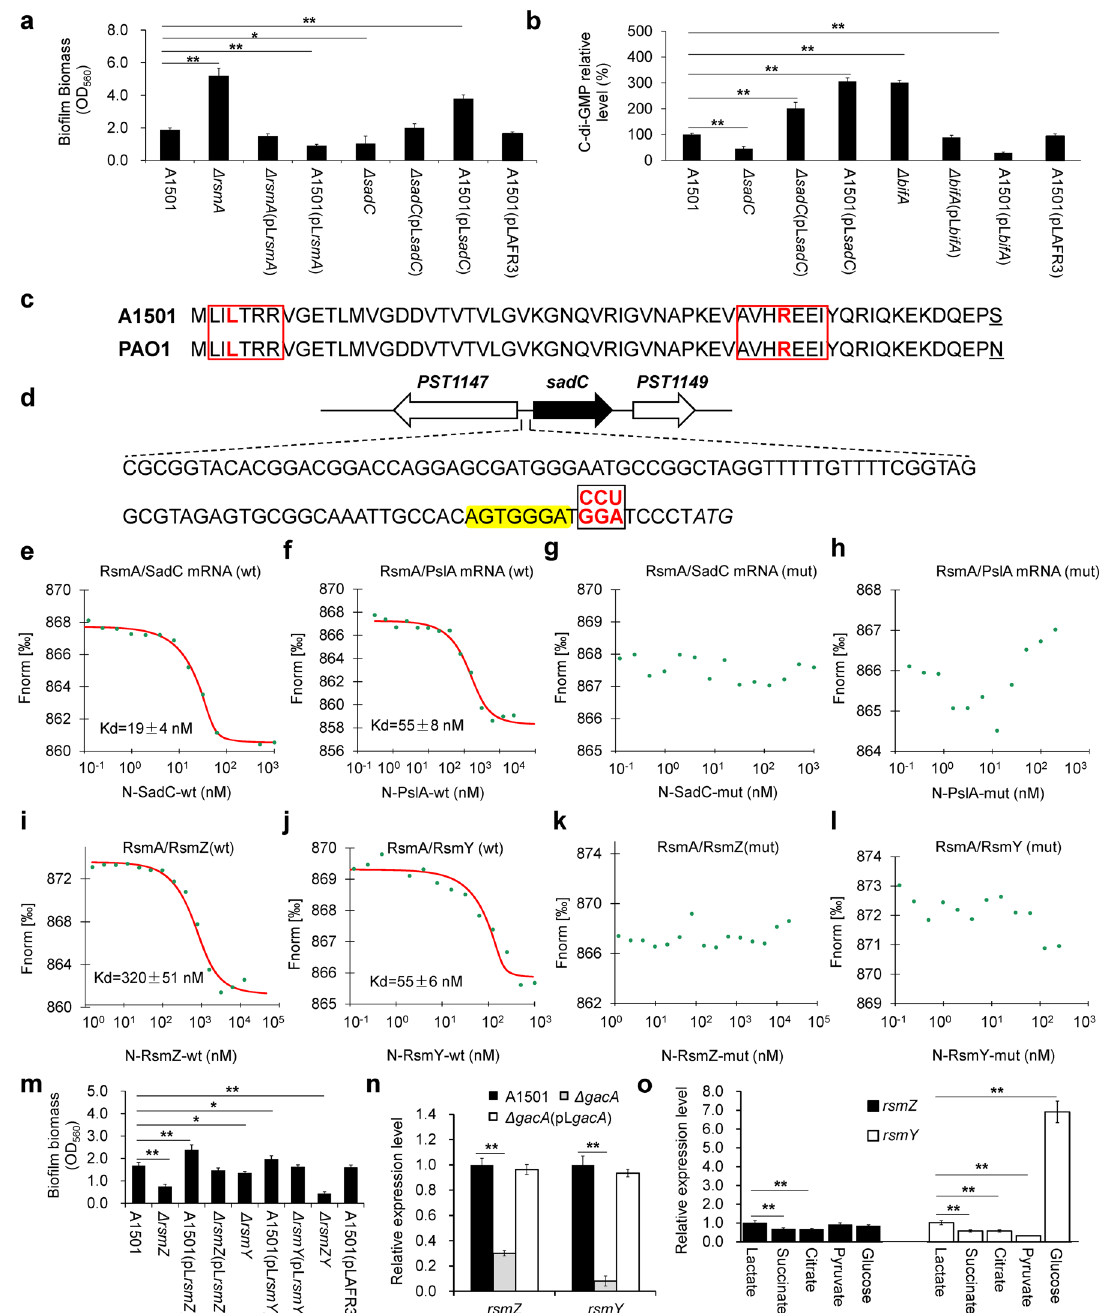
Fig. 4 Involvement of Gac/Rsm pathway genes in bio fi lm formation. a Bio fi lm formation measured 48 h after inoculation by crystal violet staining of the WT A1501 and its derived strains. b Relative c-di-GMP levels of the WT A1501 and its derived strains. c Primary sequence alignment of the P. aeruginosa and A1501 RsmA proteins showing sequence similarities. Regions L and R, thought to mediate RNA binding, are boxed in red. d The sadC promoter region of P. stutzeri A1501. The GGA motif is shown in red, and the corresponding mutated sequence in the synthesised oligonucleotide N-SadC-mut, containing the 5 ′ -UTR of sadC mRNA, is shown above the GGA motif. The putative ribosome-binding site is highlighted in yellow. e – l Determination of the binding af fi nity of Cy3-labelled RsmA to the target mRNAs or ncRNAs containing the WT or mutated GGA motifs, respectively. Point mutations introduced into synthesised oligonucleotide derivatives are shown in red. Ligand- dependent changes in MST are plotted as normalised fl uorescence ( F norm ) values vs. ligand concentration in a dose – response curve. F norm values are plotted as parts per thousand [ ‰ ] for binding af fi nity analysis. N, ssRNA oligonucleotide; wt, wild type; mut, mismatch mutation. m , Effects of rsmZ and rsmY deletion and overexpression on bio fi lm formation. n Effect of gacA mutation on the expression of rsmZ and rsmY . o Relative expression levels of rsmZ and rsmY in bio fi lm cells grown on lactate versus other carbon substrates. Asterisks indicate statistical signi fi cance by one-way ANOVA with LSD multiple-comparison test: * p < 0.05; ** p <